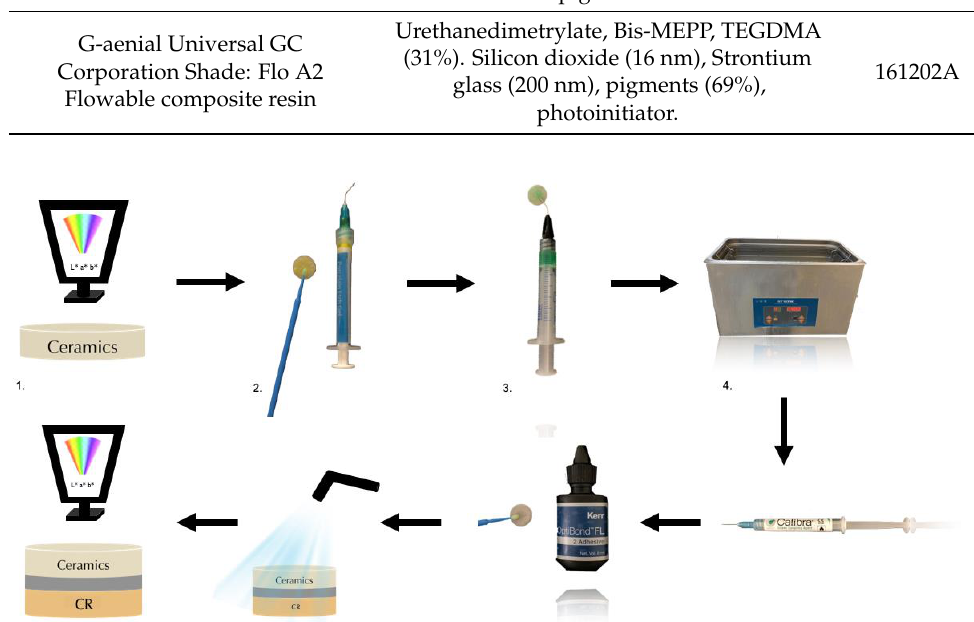
Figure 1. Diagram of the study design. ( 1 ) Ceramic L*a*b measurement; ( 2 ) 9.6% hydrofluoridric acid; ( 3 ) 37% orthophosphoric acid; ( 4 ) ultrasonic bath; ( 5 ) silane; ( 6 ) adhesive; ( 7 ) ceramic luting with different cements; ( 8 ) cemented ceramic L*a*b measurement. Color was determined according to the CIELAB color scale relative to the standard illuminant D65 on a reflection spectrophotometer (Spectro Shade, MHT S.p.A., Milan, It- aly), allowing the object ’ s transmittance and spectral reflectance measurement under